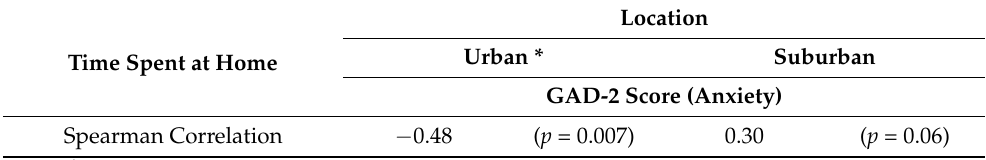
Table 4. Summary statement on the Spearman correlation of participants.